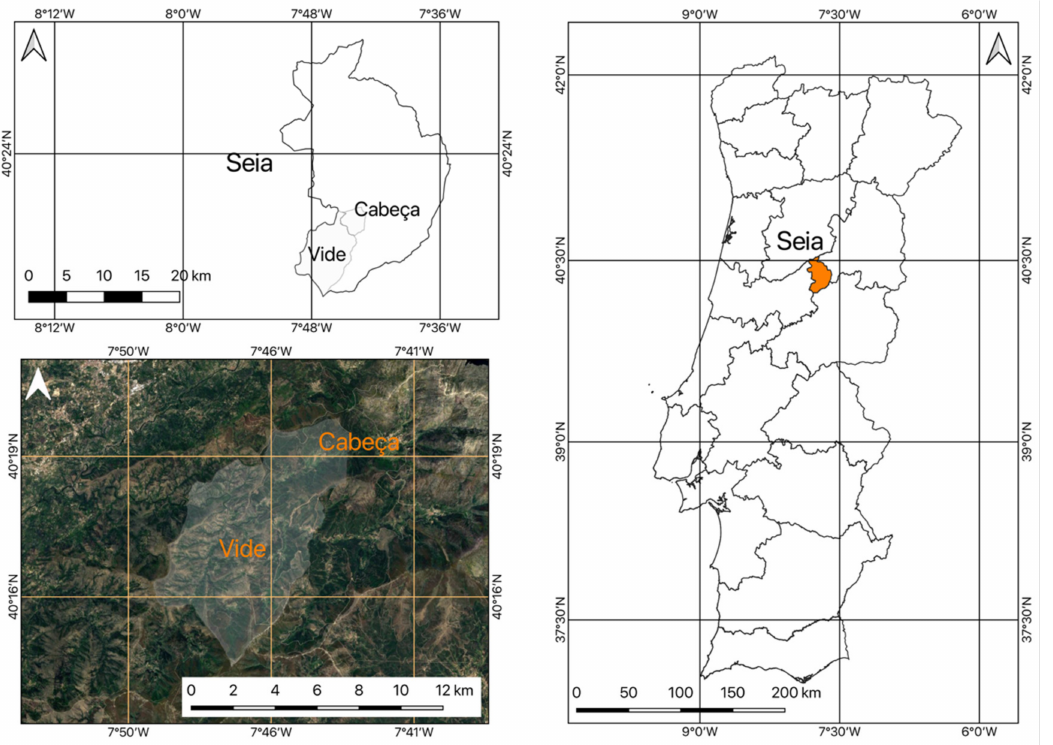
Figure 3. Location of the area under